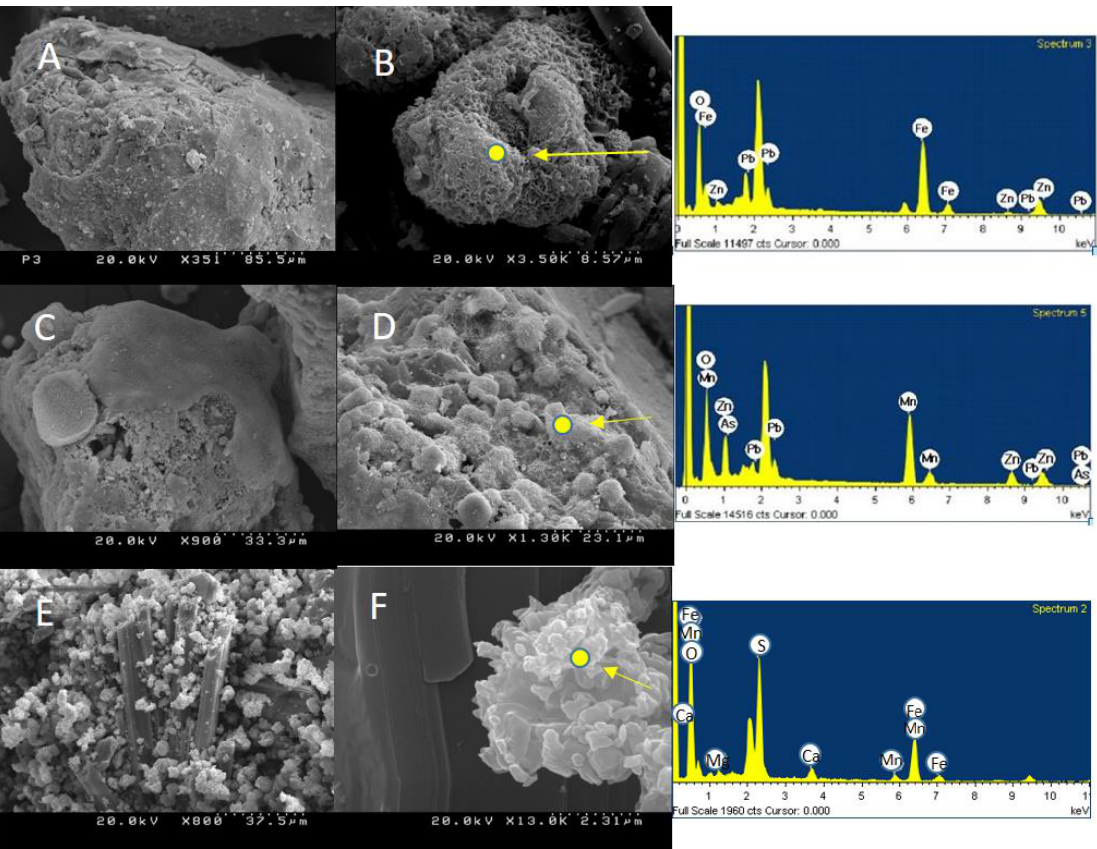
Figure 3. Scanning electronic microscope images and energy-dispersive X-ray spectroscopy results of the sample collected from point 1 and 2: ( A ) and ( B ): Goethite, ( C ) and ( D ): Mn oxide, ( E ) and ( F ): Schwertmannite formed on the gypsum crystal.